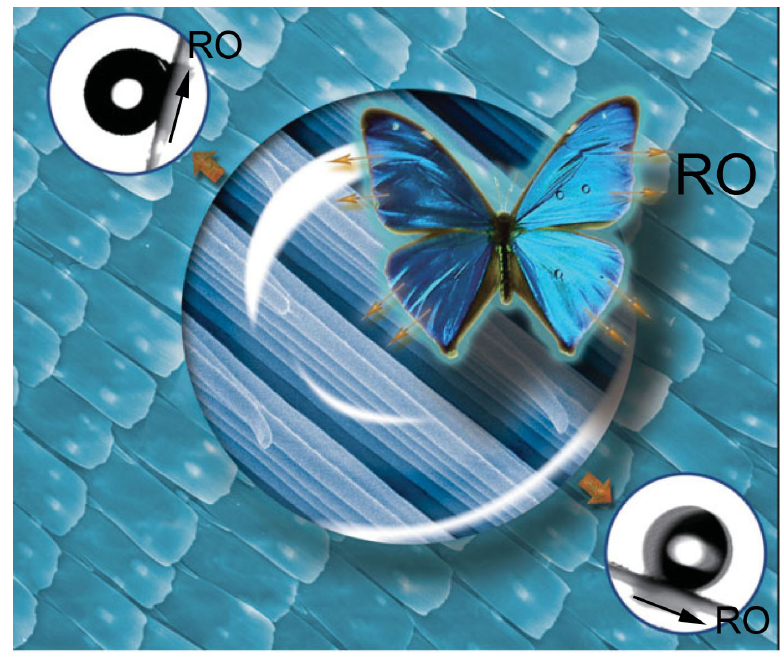
Figure 6. Directional adhesion on superhydrophobic butterfly wings. Morpho aega butterfly with arrows indicating radial outward (RO) direction away from the central axis of the body. The droplet easily rolls of wing in the RO direction when wing is tilted downward by as low as 9 ◦ (bottom right). A water droplet is tightly pinned against wing’s surface when tilted upward up to 90 ◦ (top left). Adapted from Xia and Jiang